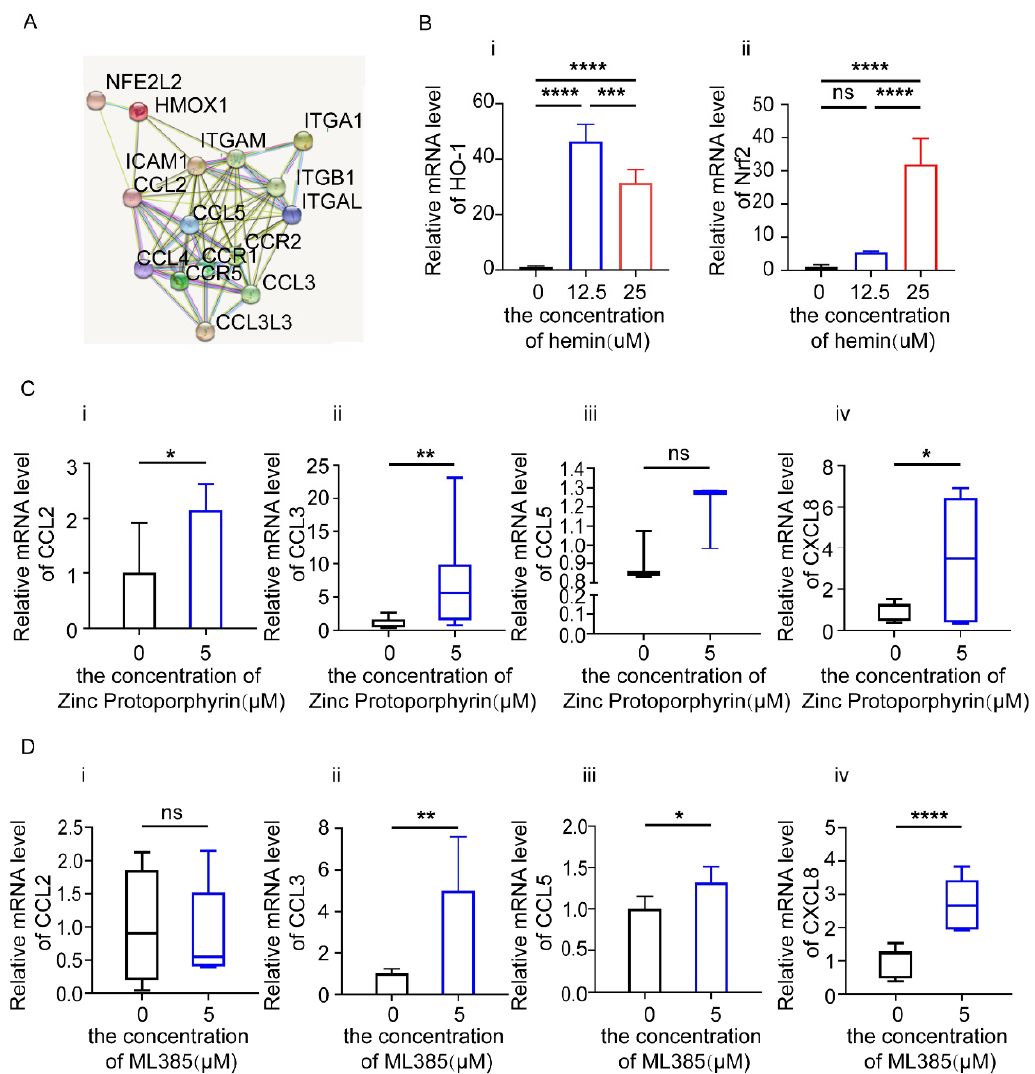
Figure 6. Blocking HO-1 and Nrf2 leads to an increase in chemokines by EECs. ( A ) The PPI network of chemokines, adhesion molecules and heme metabolism-related factors. ( B ) Relative mRNA expression of HO-1 and Nrf2 in EECs treated with Hemin at a concentration of 0 μ M, 12.5 μ M and 25 μ M for 48 h. ( C ) Relative mRNA expression of CCL2 , CCL3 , CCL5 , CXCL8 in EECs treated with HO-1 inhibitor (Zinc Protoporphyrin) at the concentration of 5 μ M for 24 h. ( D ) Relative mRNA expression of CCL2 , CCL3 , CCL5 , CXCL8 in EECs treated with Nrf2 inhibitor (ML385) at the concentration of 5 μ M for 24 h. Data are presented as the mean ± standard error of the